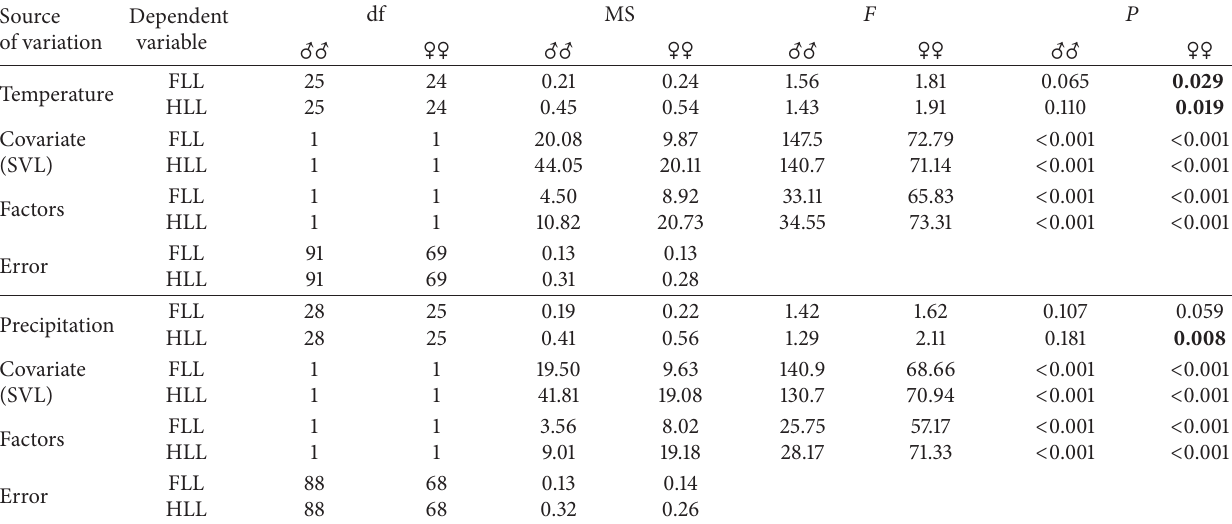
Table 7: Results of a MANCOVA examining the effect of temperature and precipitation on total fore limb length (FLL) and total hind limb length (HLL) in Mesalina guttulata with SVL as a covariate. Significant effects are marked in bold